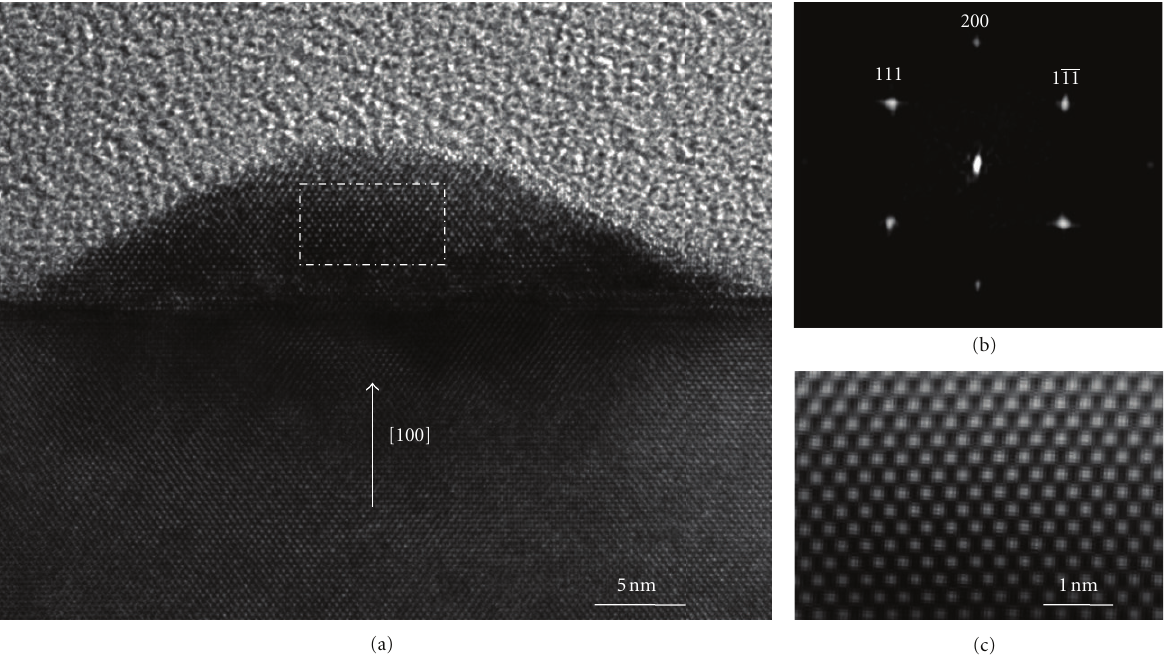
Figure 12: (a) A cross-section TEM image of a typical Mn 0 . 05 Ge 0 . 95 QD. (b) A fast Fourier transformation (FFT). (c) A high-resolution TEM image of the MnGe lattice through the Fourier filter, showing a perfect coherence. Reproduced from [17]. Copyright ©2010, Macmillan Publishers Limited.